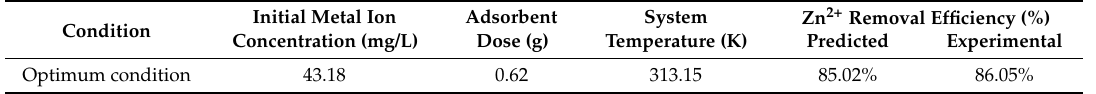
Table 6. Optimum conditions for the removal of aqueous phase Zn 2+ on the composite